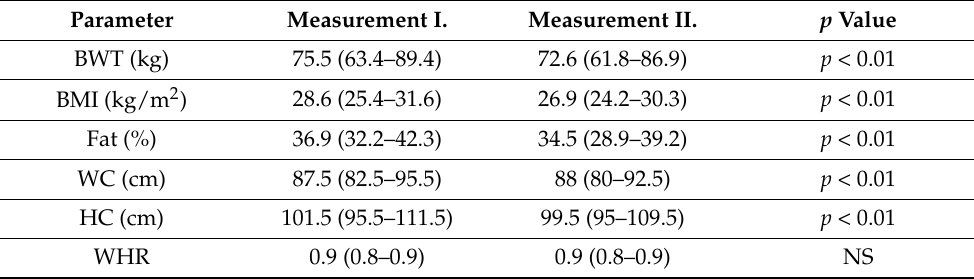
Table 2. Evaluation of nutritional state—common data set.